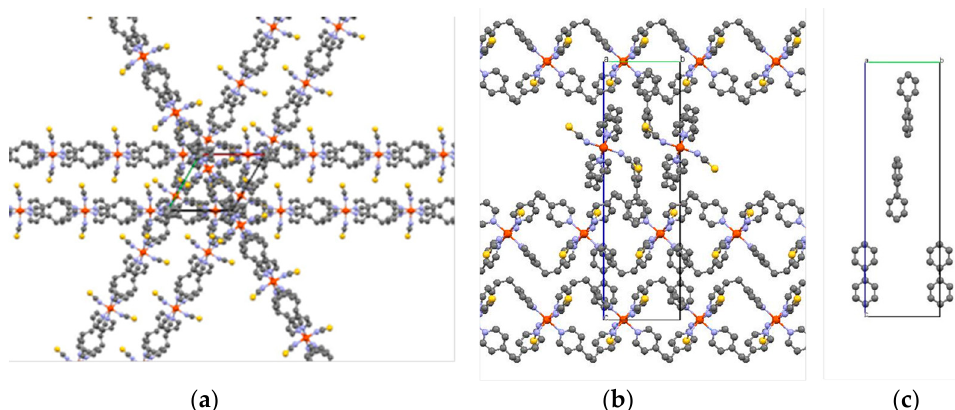
Figure 2. The projections of [[Fe(NCS) 2 (bpa) 2 ] · biphenyl] n to ab plane ( a ), a axis ( b ), and the projection of biphenyl to a axis ( c ).